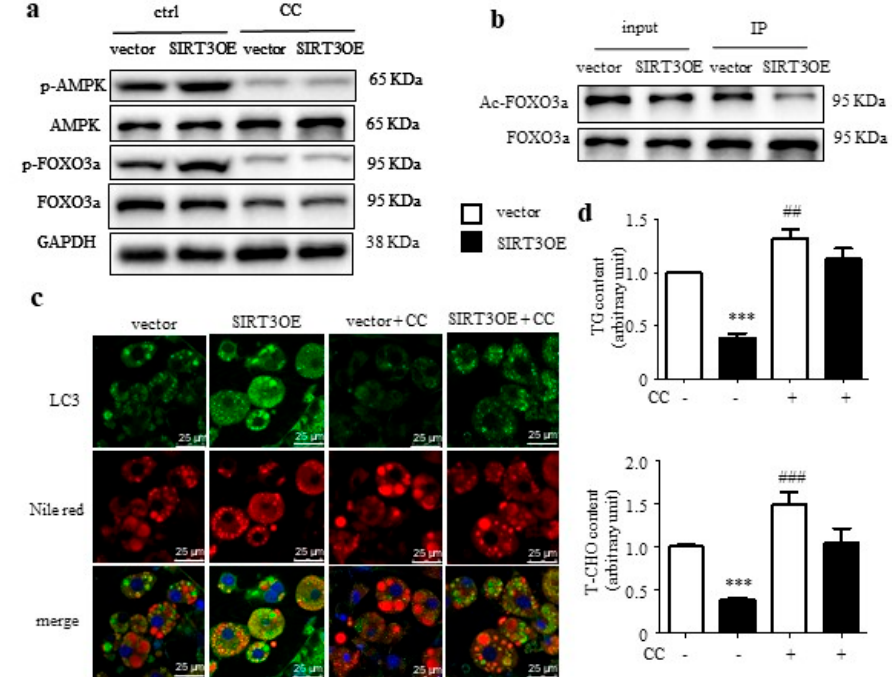
Figure 3. SIRT3-induced macroautophagy is mediated through activating AMPK in adipocytes. ( a ) p-AMPK, AMPK, p-FOXO3a, and FOXO3a expression in vector and SIRT3OE cells treated with or without CC. GAPDH was used as a loading control. ( b ) Acetylated and total FOXO3a protein levels in vector and SIRT3OE cells. ( c ) Immunofluorescence of LC3 (green) and fluorescence of Nile Red (red) in SIRT3OE and vector cells treated with or without CC. Nuclei were stained with DAPI (blue). Scale bar = 25 µ m. ( d ) TG and T-CHO levels in vector and SIRT3OE cells treated with or without CC for 16 h. Data represented means ± S.D., n = 6, *** p < 0.001 vector versus SIRT3OE cells. ## p < 0.01 and ### p < 0.001 vehicle control versus CC treated cells.